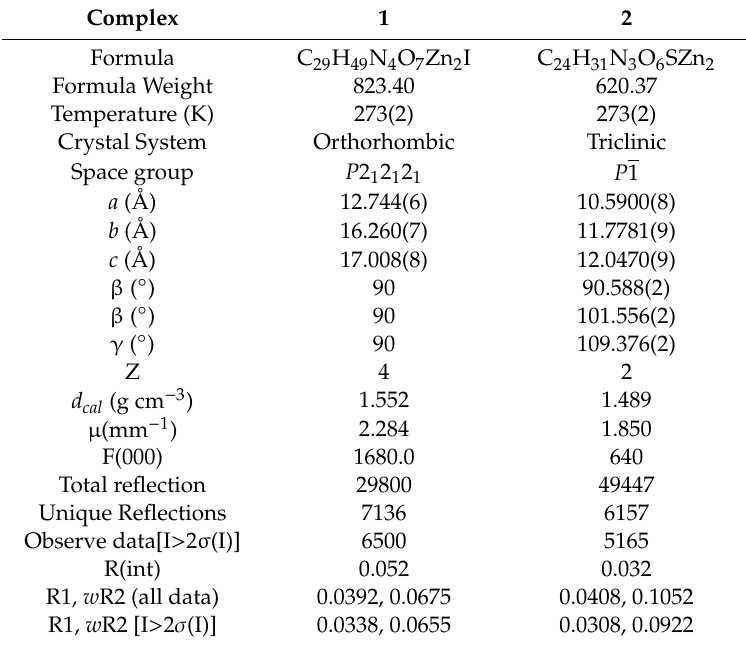
Table 4. Crystal data and refinement details of complexes 1 and 2